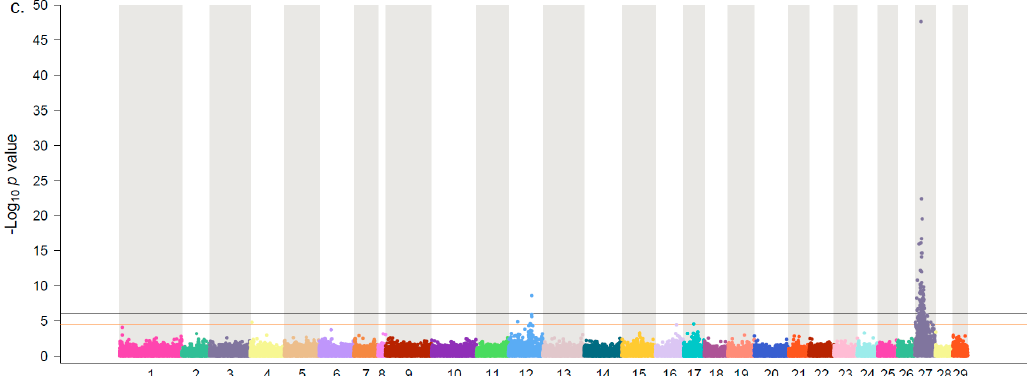
Figure 3. Manhattan plot of association analysis to CMS resistance in Atlantic salmon. The figures show the − log 10 p -value of the test statistics for each SNP plotted against the physical positions of the markers on the chromosomes. The black and orange lines indicate the genome-wide and chromosome-wide significance threshold cut-off levels, respectively. ( a ) SalmoBreed population, year-class 2018 (SB-18); ( b ) StofnFiskur 2017 year-class (SF-17), and ( c ) meta-analysis based on three populations, SB-17, SB-18 and SF-17.